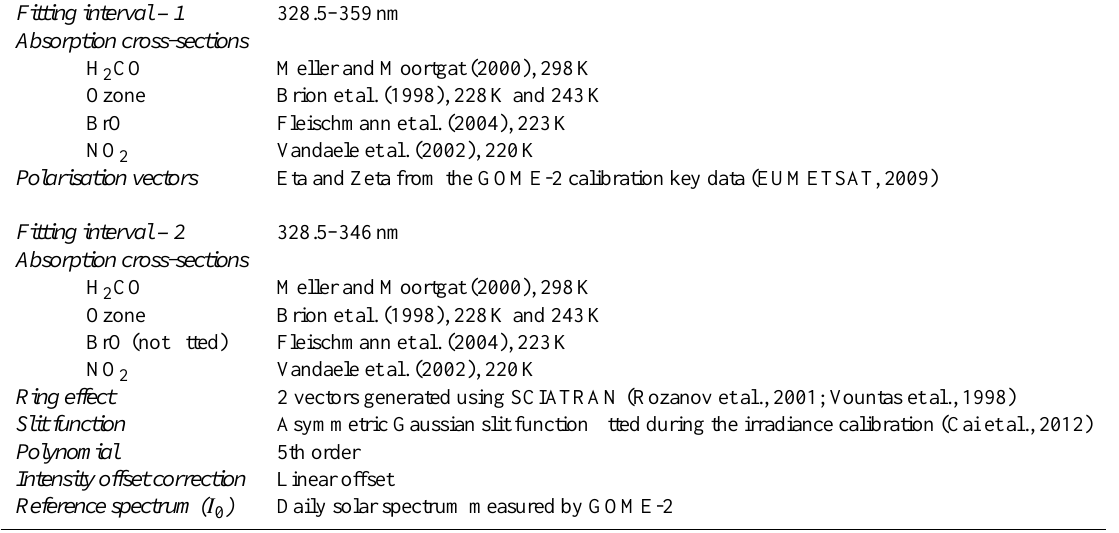
Table 2. Improved DOAS settings (v12) used to retrieve H 2 CO slant columns from GOME-2 spectra.